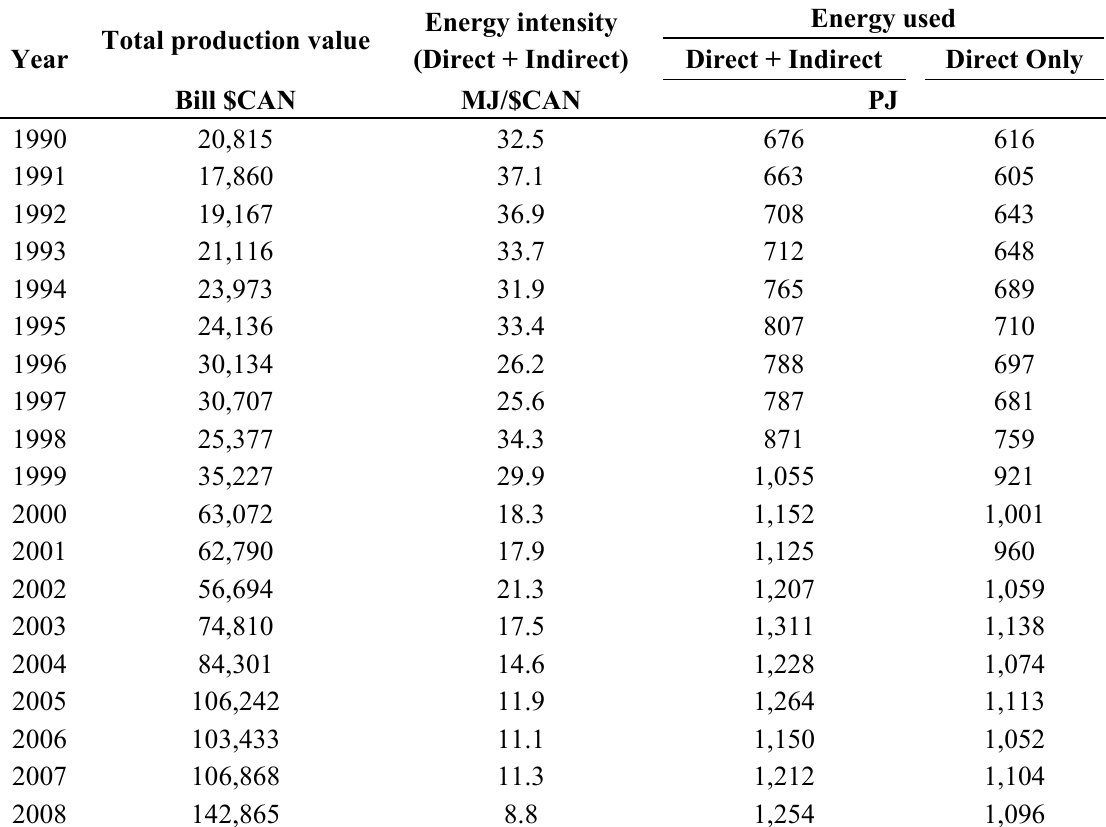
Table 4. Direct and indirect energy use in the oil and gas extraction sector